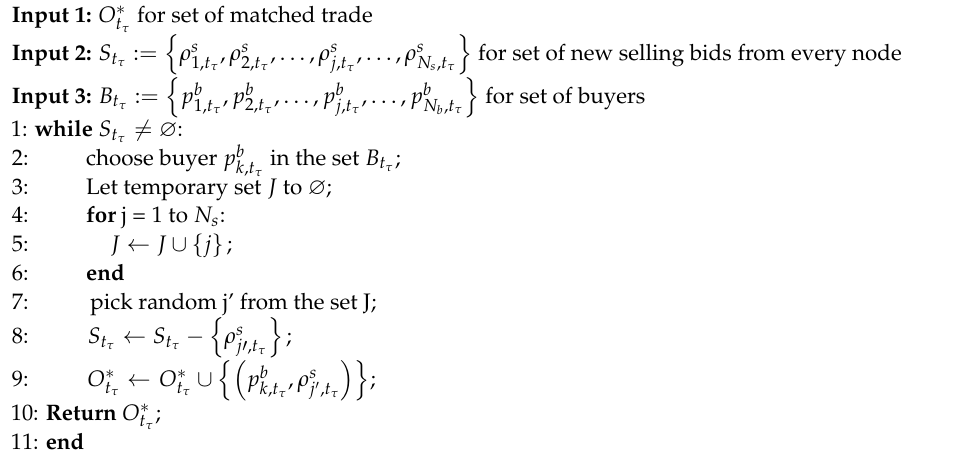
Algorithm 1. Matching algorithm for buyer i ∈ N b at time t τ in the random transaction